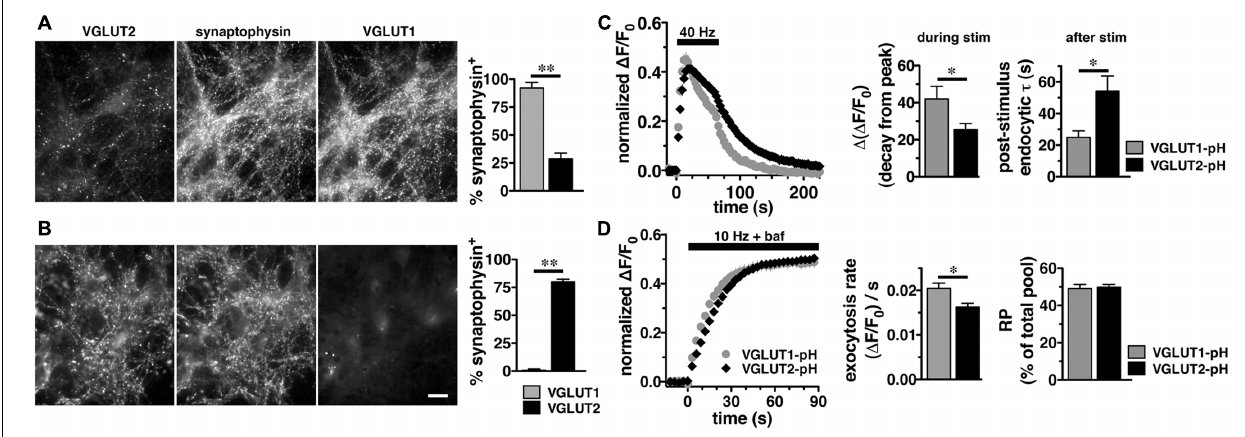
FIGURE 3 | Vesicular glutamate transporter 2-pH retains distinct recycling kinetics from VGLUT1-pH in different neuronal populations. (A) Cultured hippocampal neurons were triple stained with antibodies to endogenous VGLUT2, synaptophysin, and VGLUT1. Right panel: Quantitation of synaptophysin + puncta that co-localize with antibody to VGLUT1 (92.00 ± 5.05%, n = 3) is greater than VGLUT2 (28.67 ± 5.15%, n = 4, ∗∗ p < 0.01) in hippocampal cultures. (B) In thalamic neurons in culture, 80.00 ± 2.28% of synaptophysin + puncta co-localize with antibody to VGLUT2 ( n = 5). VGLUT1 staining was virtually undetectable (0.80 ± 0.49%, n = 5). Data are the mean ± SEM of 3–5 coverslips from at least two independent cultures. Scale bar, 10 µ m. (C) Left panel: The time course of exo- and endocytosis of VGLUT2-pH (black) or VGLUT1-pH (gray) in response to electrical stimulation in thalamic synaptic boutons is similar to hippocampus. Middle panel: The extent of VGLUT2-pH fluorescence decay from peak during stimulation is less for VGLUT2-pH (black, 25.41 ± 3.32%, n = 8) than VGLUT1-pH (gray, 42.02 ± 6.85%, n = 6, ∗ p < 0.05). Right panel: The post-stimulus endocytic rate of VGLUT2-pH (black, τ = 54.32 ± 9.34 s) is also significantly slower than that of VGLUT1-pH (gray, τ = 24.89 ± 4.18 s, ∗ p < 0.05). (D) Left panel: Exocytosis upon stimulation at 10 Hz for 90 s (bar) is measured in the presence of bafilomycin. Middle panel: As in hippocampus, VGLUT2-pH expressed in thalamic neurons exhibits a slower initial rate of exocytosis than VGLUT1-pH, calculated as the linear rate of fluorescence change from 0 to 15 s [( (cid:49) F/F 0 )/s VGLUT2-pH, 0.0162 ± 0.0008, n = 8; VGLUT1-pH, 0.0205 ± 0.0012, ∗ p < 0.05, n = 9]. Right panel: In response to 900 action potentials, fluorescence of VGLUT2-pH and VGLUT1-pH plateaus at a similar level, indicating that there is no significant